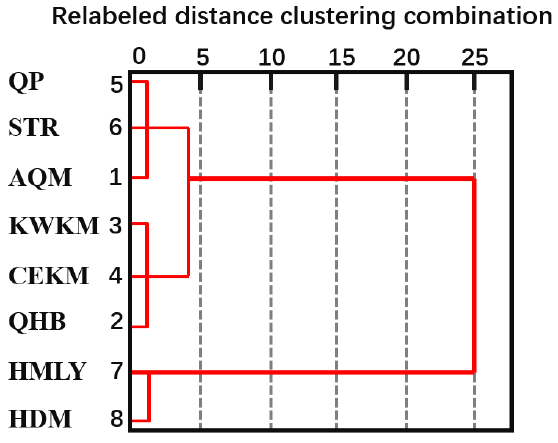
Figure 10. Pedigree of systematic cluster analysis.